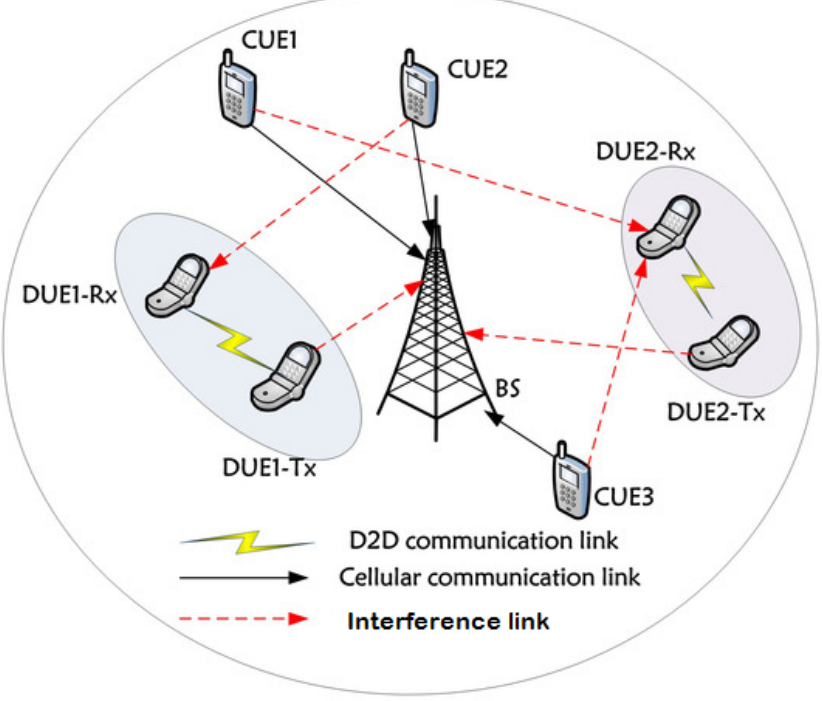
Figure 1. D2D communications—interference